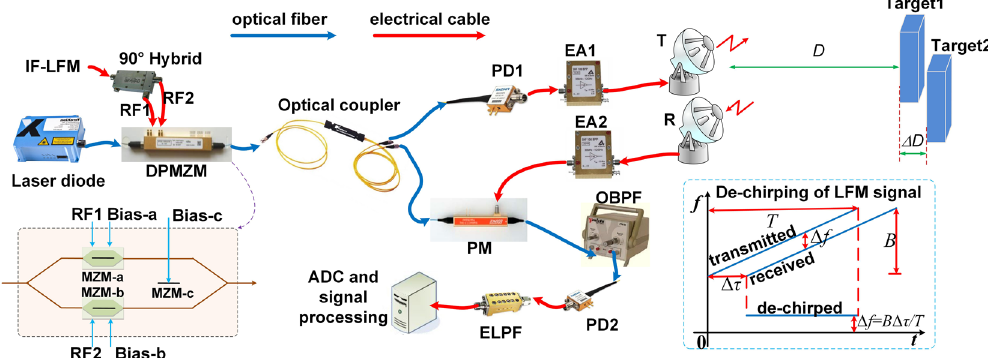
Figure 1. Setup of the proposed photonics-based radar. DPMZM: dual-parallel Mach-Zehnder modulator; PD: photodetector; PM: electro-optical phase modulator; OBPF: optical bandpass filter; ELPF: electrical low-pass filter; ADC: analog-to-digital conversion. Inset: principle for de-chirping of a LFM